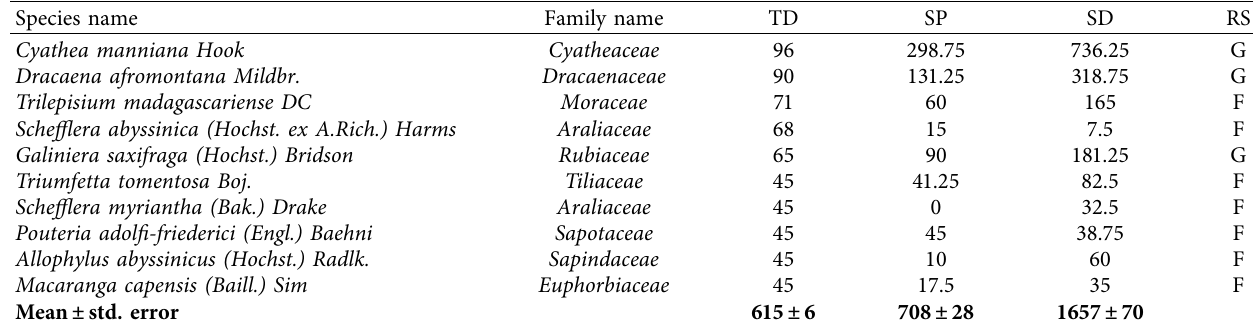
Table 14: Regeneration status of top ten species in site IV (Kabo–Gumare).